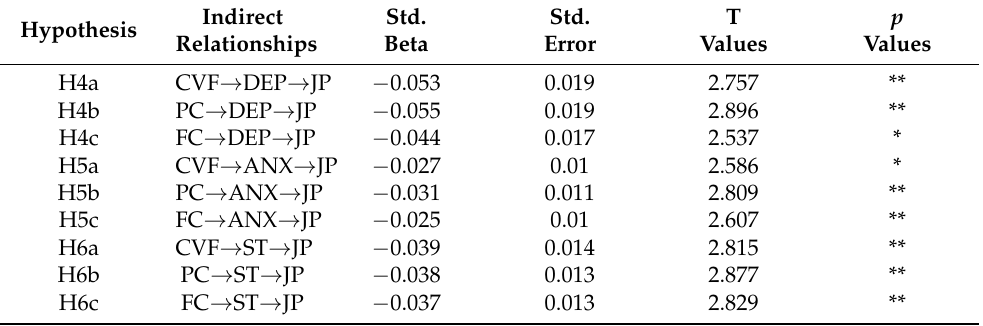
Table 10. Hypotheses testing Mediation Effect.